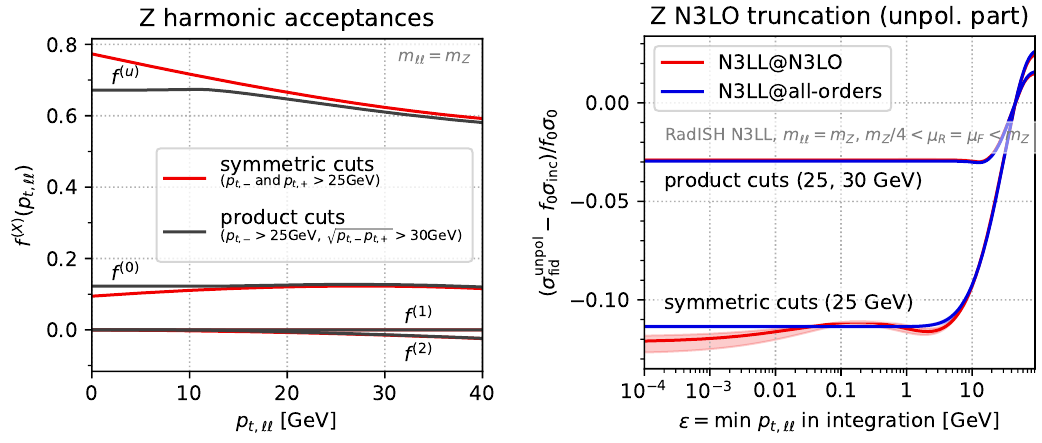
Figure 15 . Left: acceptances for the non-zero spherical harmonics, as defined in eq. (6.4), for √ symmetric cuts ( p t,‘ > 25 GeV , in red), and product cuts ( p t, + p t, − > 30 GeV , supplemented with a minimum cut p t, − > 25 GeV , in black). Right: the unpolarised part of the cross section (i.e. corresponding to f ( u ) ) within an all-order N3LL calculation (in blue) and its truncation at N3LO (in red), as a function of the minimum p t,‘‘ that is allowed in the integration. The results are shown for the same symmetric and product cuts as in the left-hand